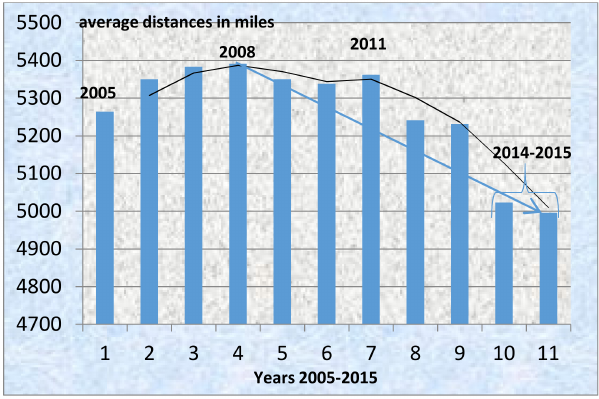
Figure 4. Average distances prevailed in CM between 2005 and 2015. Source: Figure 3, excel and author. Trend: a two-year moving